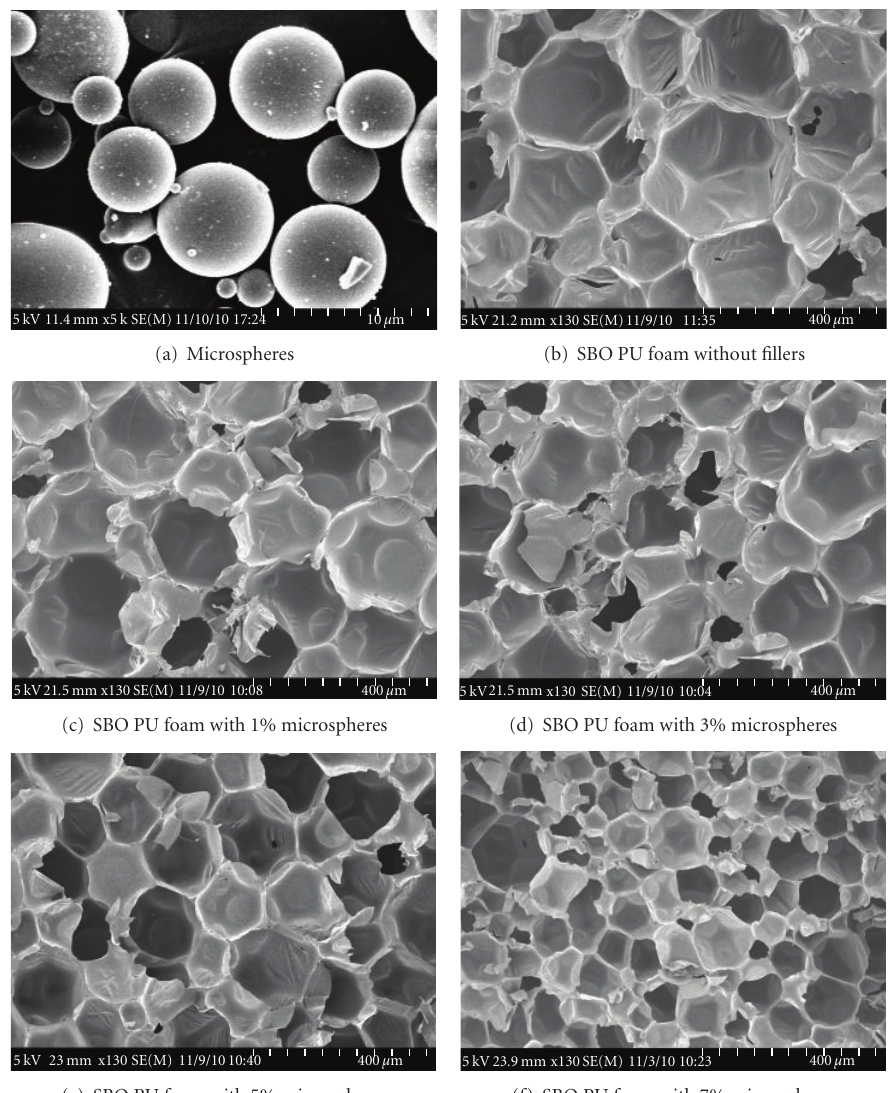
Figure 3: Scanning electron micrographs of SBO PU foams modified with